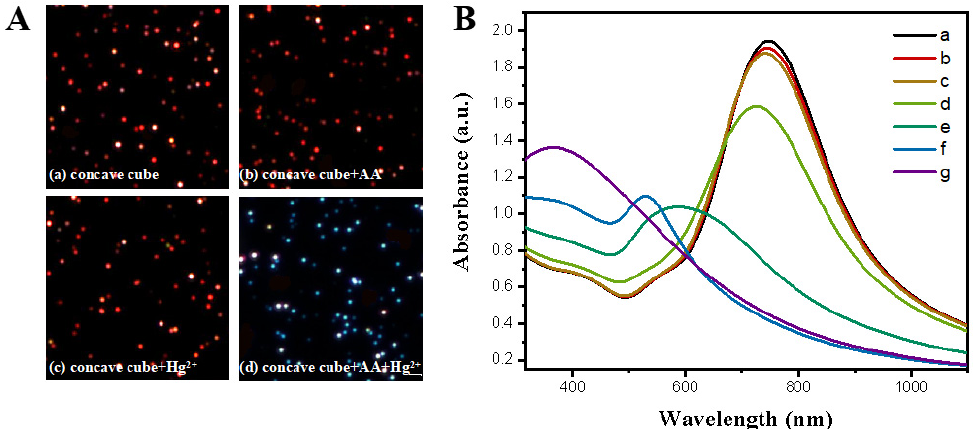
Figure 2. ( A ) Representative DFM images of concave cube Au nanoparticles in water (a), 80 μ M AA solution (b), 200 µ M Hg 2+ solution (c), and 80 µ M AA + 40 µ M Hg 2+ solution (d). ( B ) The UV-Vis spectra: concave cube Au nanoparticles (a), concave cube Au nanoparticles + 80 µ M AA (b), concave cube Au nanoparticles + 200 µ M Hg 2+ (c), concave cube Au nanoparticles + 80 µ M AA + 5 µ M Hg 2+ (d), concave cube Au nanoparticles + 80 µ M AA + 50 µ M Hg 2+ (e), concave cube Au nanoparticles + 80 µ M AA + 100 µ M Hg 2+ (f), and concave cube Au nanoparticles + 80 µ M AA + 200 µ M Hg 2+ (g).